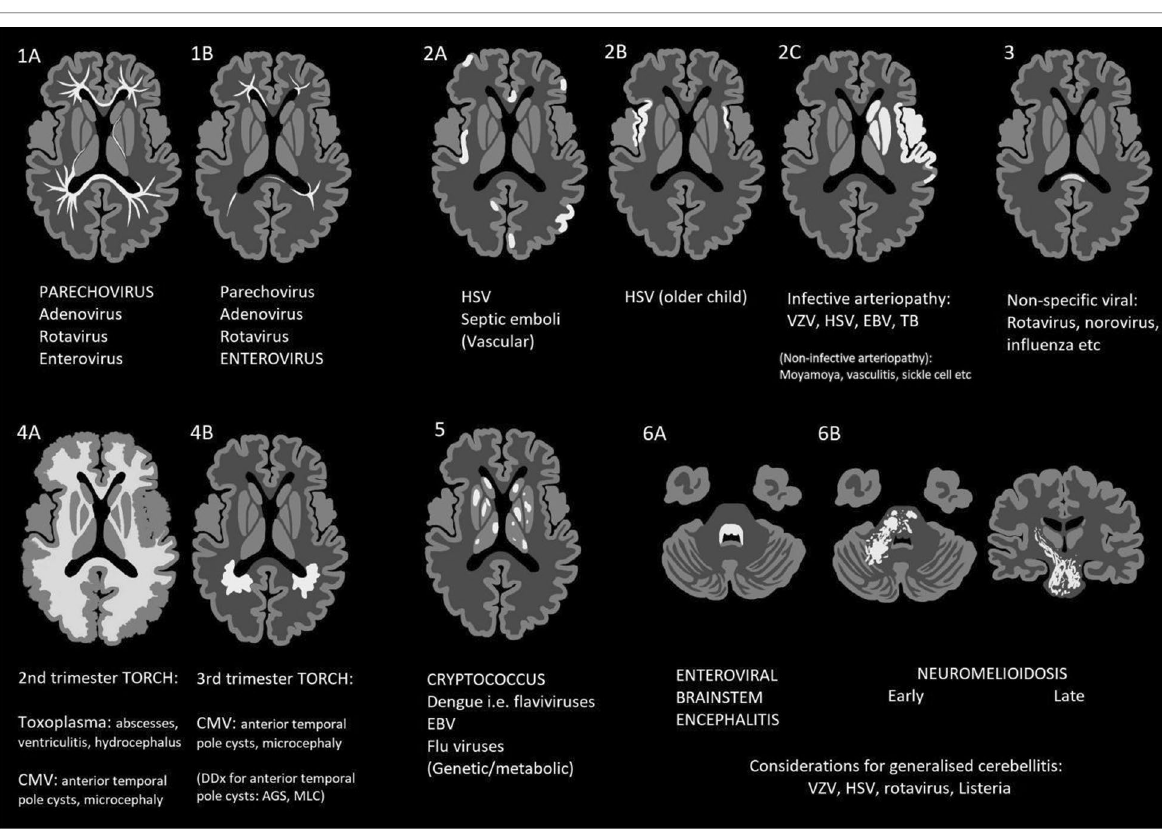
Fig. 19 MRI patterns of paediatric brain infections, with differentials relevant to the WA environment. A summary of the key MRI patterns and their sub‑patterns as discussed in this review, with the causative pathogens tailored to the WA